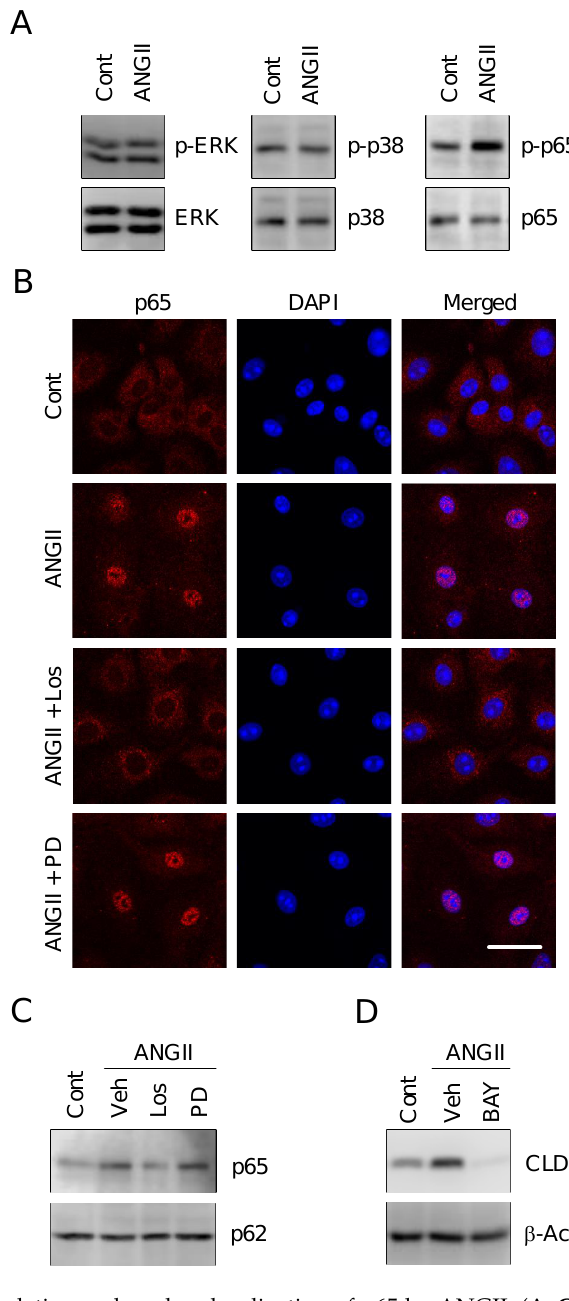
Figure 6. Phosphorylation and nuclear localization of p65 by ANGII. ( A – C ) Cells were incubated in the absence (Cont) and presence of 10 µM ANGII for 30 min. ( A ) Cytoplasmic extracts including membrane and cytoplasmic proteins were immunoblotted with anti-p-ERK, ERK, p-p38, p38, p-p65, or p65 antibody. ( B ) The cells were stained with p65 (red) and DAPI (blue). The scale bar represents 10 µm. ( C ) Nuclear fractions were immunoblotted with anti-p65 or nucleoporin p62 antibody. ( D ) Cells were incubated in the absence (Cont) or presence of 10 µM ANGII and 10 µM BAY for 24 h. Cytoplasmic extracts were immunoblotted with anti-CLDN7 or β-actin antibody.